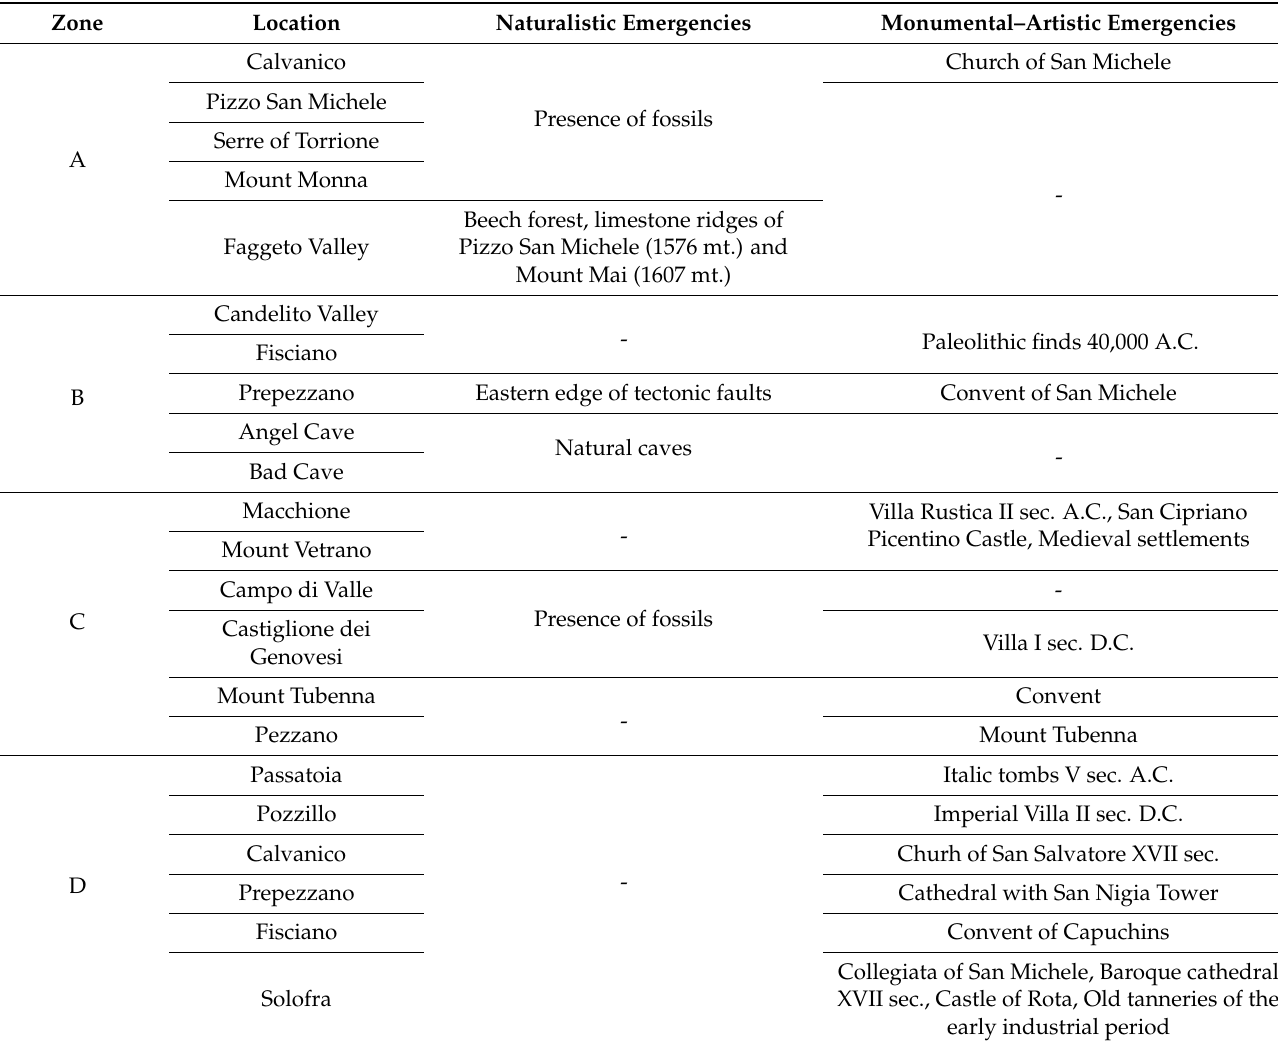
Table 1. Naturalistic and anthropic